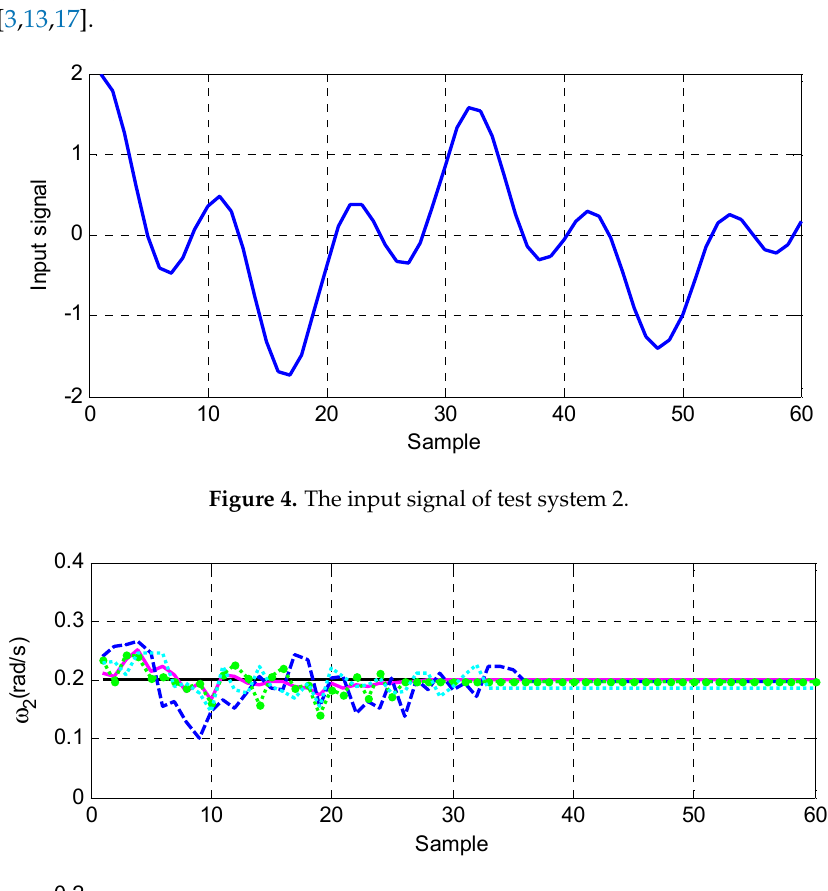
Table 2. Identified results of different methods.